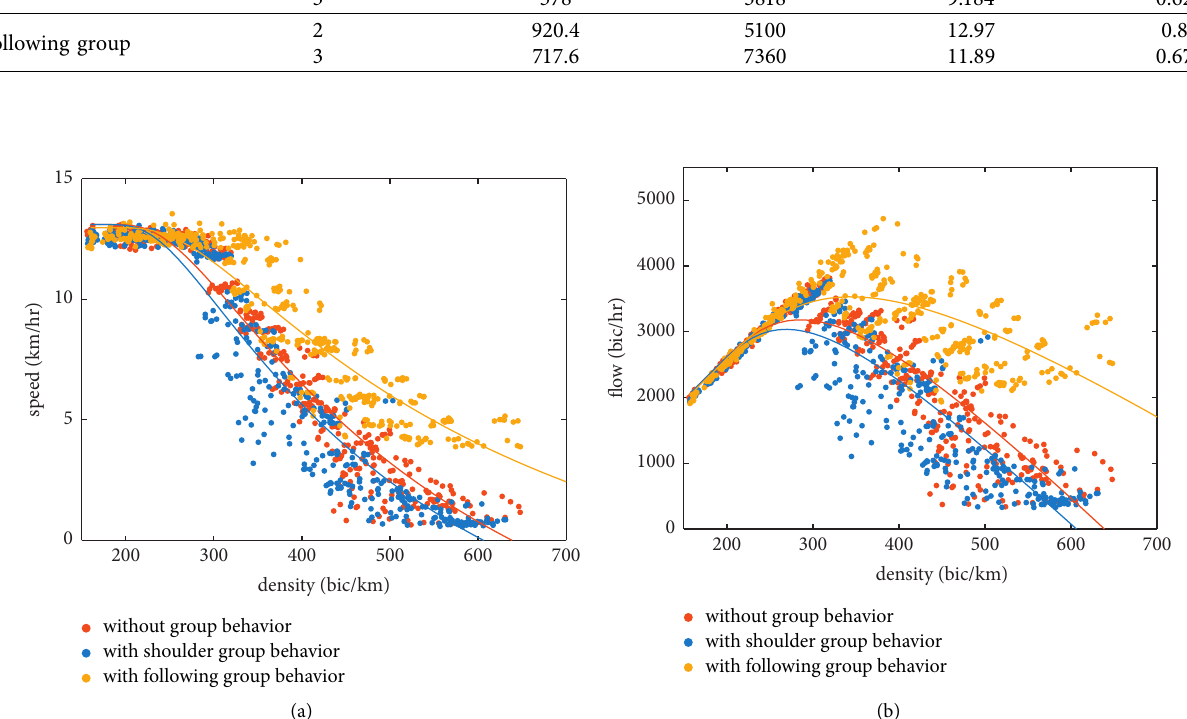
Figure 9: Fundamental diagrams under three kinds of bicycle flow. (a) Speed vs. density. (b) Flow vs. density.